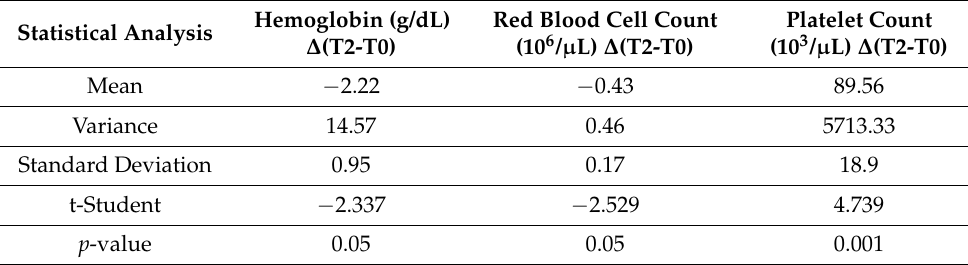
Table 6. Parameters showing significant variations between T2 and T0 in standard of care (SOC)- treated COVID-19